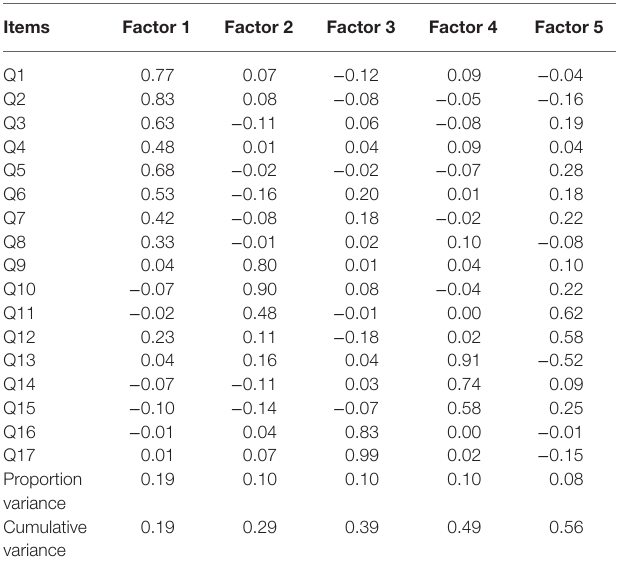
TABLE 4 | Polychoric matrices of rotated components of the knowledge and perception questionnaire of pesticide exposure for schoolchildren. Items Factor